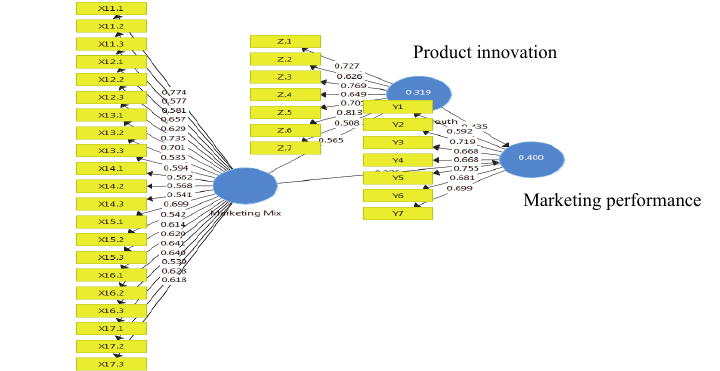
Fig. 3. Path Diagram